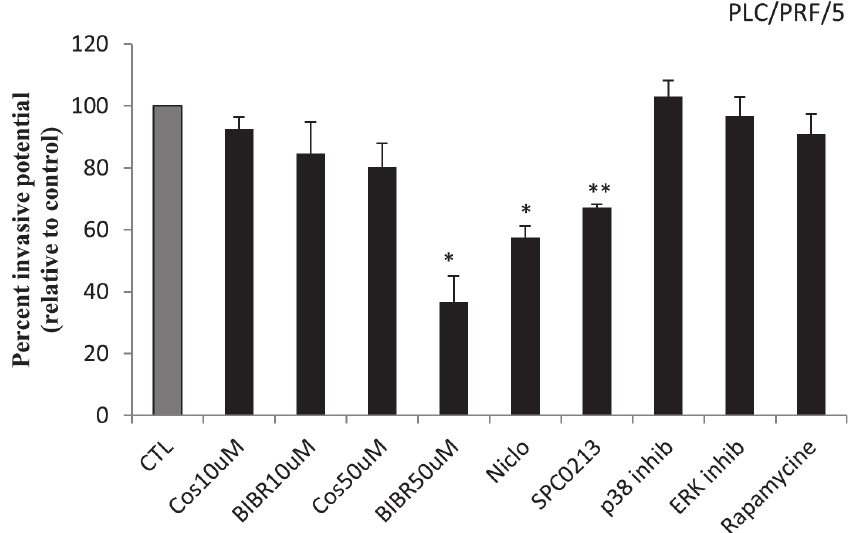
Fig 5. Effect of telomerase, mTOR and PKC inhibitors on PLC/PRF/5 cell invasion. The invasion of PLC/ PRF/5 cells was assayed using the Boyden chamber technique in a 24-well plate. According to the manufacturer ’ s recommendations, 10 6 cells in DMEM without serum were suspended in the upper chamber of each well. The same medium supplemented with 10% serum was added to the lower chamber of each well as a chemo-attractant solution. After 48 h, the cells that invaded the bottom of the membrane were stained. An extraction solution was then added, and the mixture was transferred to a 96-well microtiter plate. The cells were quantified at 560 nm using a plate reader. BIBR1532 (50 μ M), niclosamide (125 nM) and SPC0213 (5 μ M) had a significant effect on PLC/PRF/5 invasion. Each value represents the mean of three assays. Each value was normalized to its own control, which was set to 100%. Each point represents the mean ± SD from all of the experiments. * P < 0.01 versus untreated cells. ** P < 0.005 versus untreated